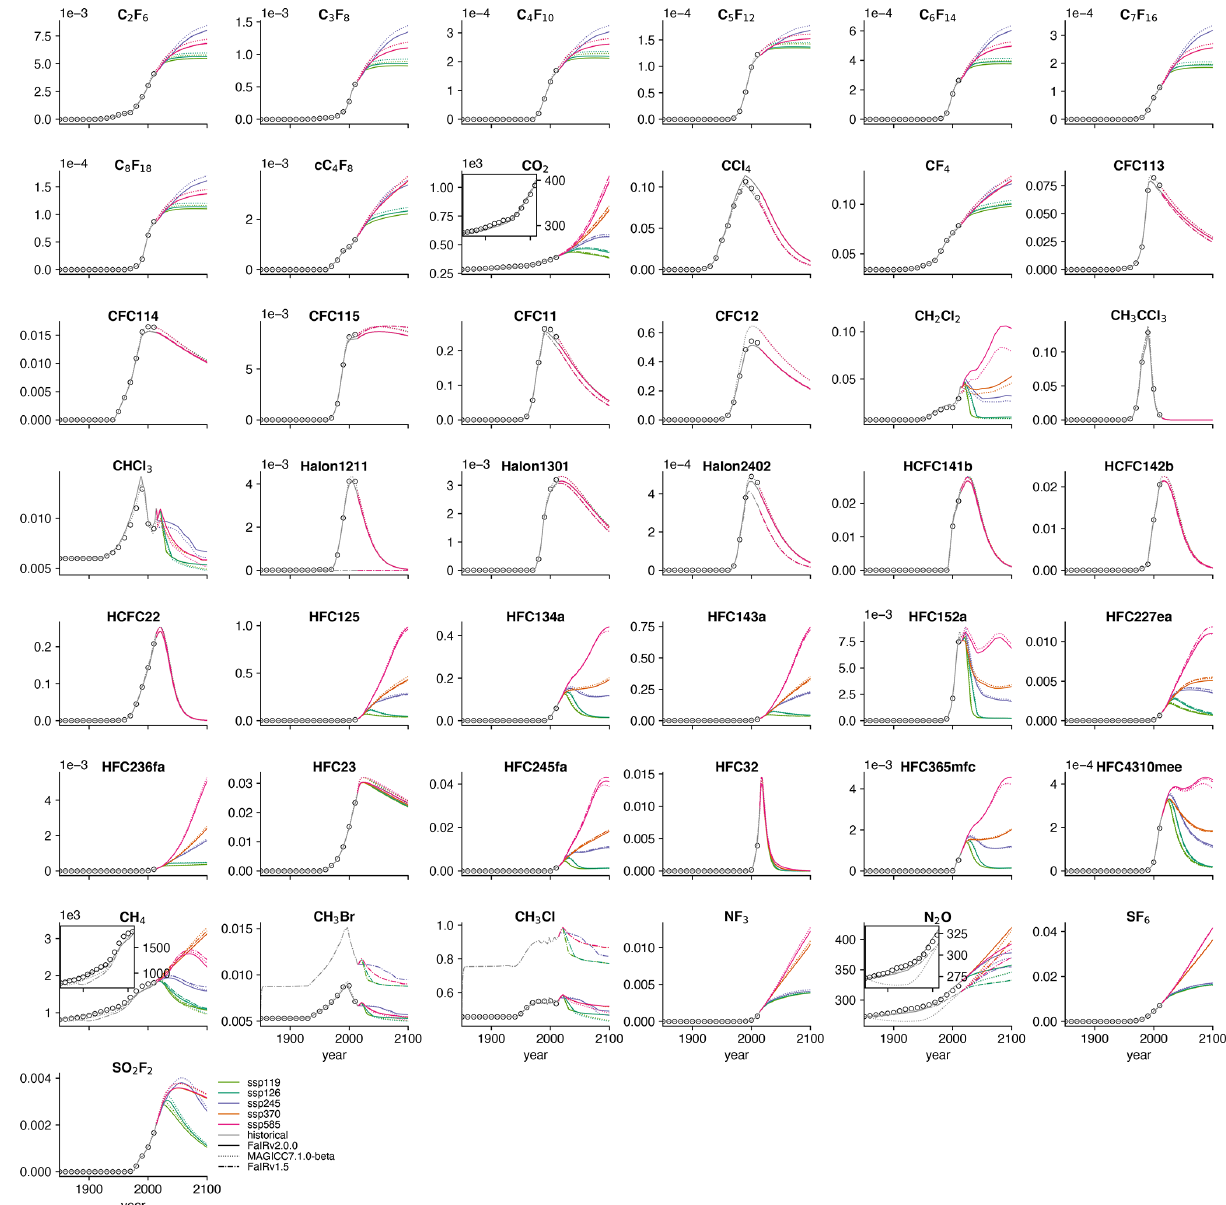
Figure 2. Comparison of historical and future concentration trajectories over a range of SSPs. Values for all GHGs are in parts per billion with the exception of CO 2 , which is plotted in parts per million. Inset panels for CO 2 , CH 4 , and N 2 O show the historic